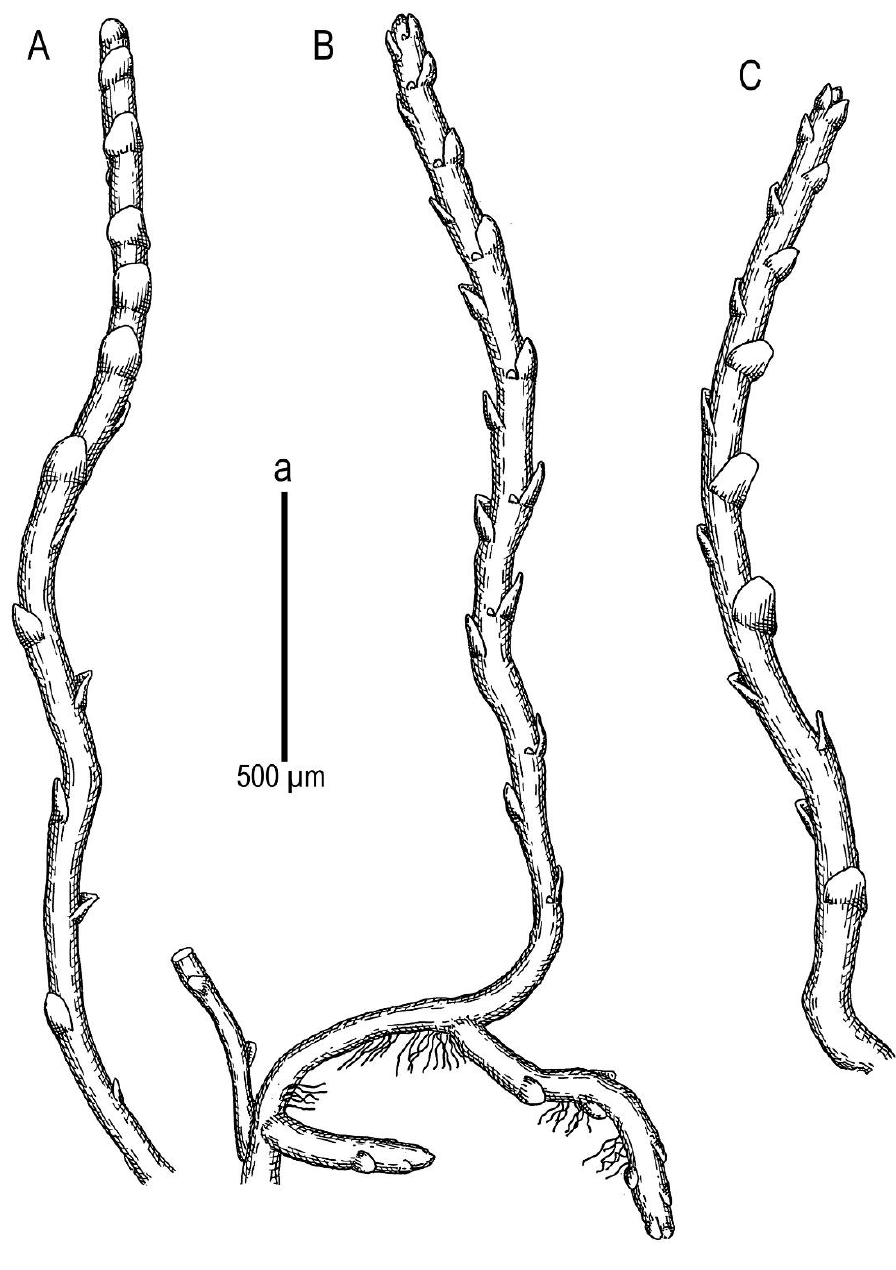
Figure 5. Marsupella praetermissa Bakalin et Vilnet sp. nov. : ( A ) plant habit, fragment, lateral view; ( B ) plant habit, fragment, ventral view; ( C ) plant habit, fragment, dorsal view. Scales: a—500 µm for ( A – C ). All from Holotype Long 35742 (E).